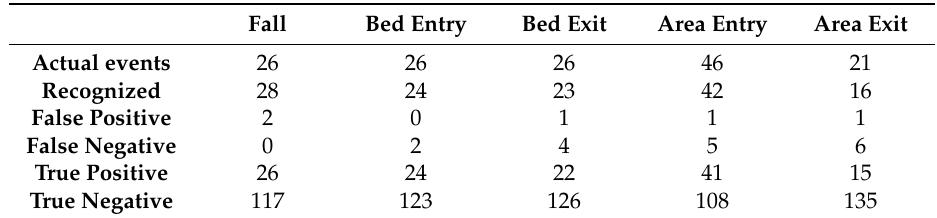
Table 10. Event recognition results.